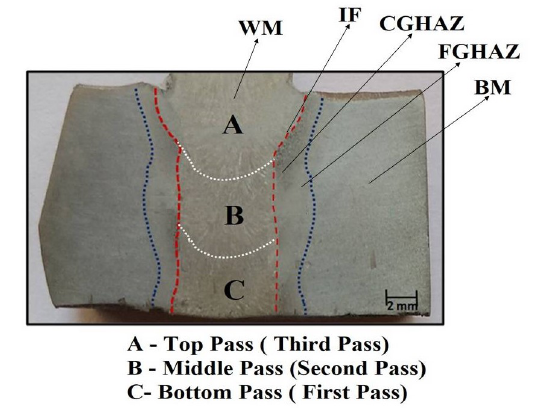
Figure 6: Macrostructure of weld joint.